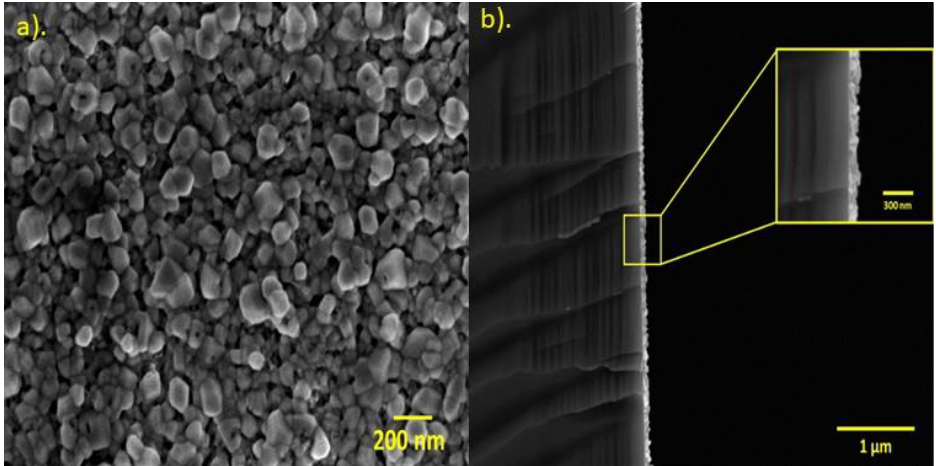
Figure 5. ( a ) The SEM images of the surface morphology of the Zn film; ( b ) the cross-sectional SEM image of the Zn film on the silicon substrate.